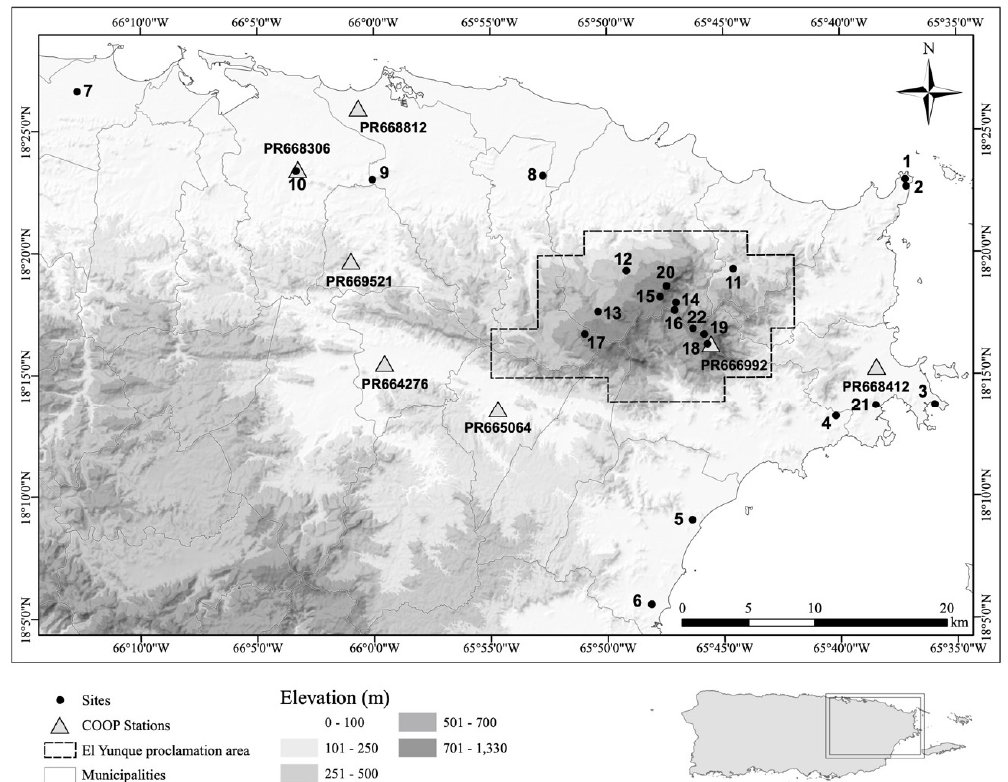
Figure 1. Map of all locations of data collection. This figure is modified from a previous study [34] to add two new sites. The map includes the National Weather Service Cooperative Observer Program (COOP) stations that collect long-term weather data in the area.